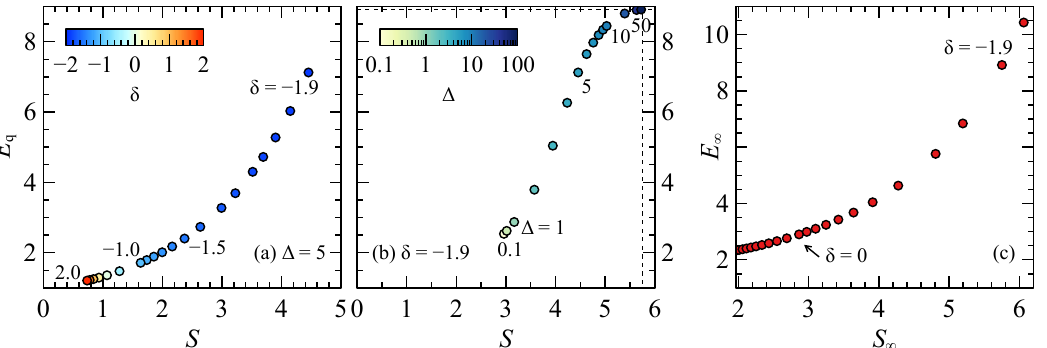
Figure 2: Entanglement entropy S as defined in (36), and quantum enhancement E q ( t ) (25) achieved by the optimal two given in (38), of the excited state population p f photon state (32) for (a) fixed detuning ∆ = 5 with variable deviation δ ∈ ( − 2;2 ] (note the colour code, and specific values indicated by labels), and (b) fixed deviation δ = − 1.9 with variable detuning ∆ ∈ [ 0.1;100 ] (colour coded and labeled). The dashed lines indicate the maximally achievable entanglement and quantum enhance- ment, respectively, in the limit ∆ → ∞ . (c) Maximally achievable enhancement E ∞ , see (43) and Sec. 3.5, and associated entanglement entropy S ∞ , given by (44), as a → function of δ , in the limit ∆ → ∞ (achieved by γ e